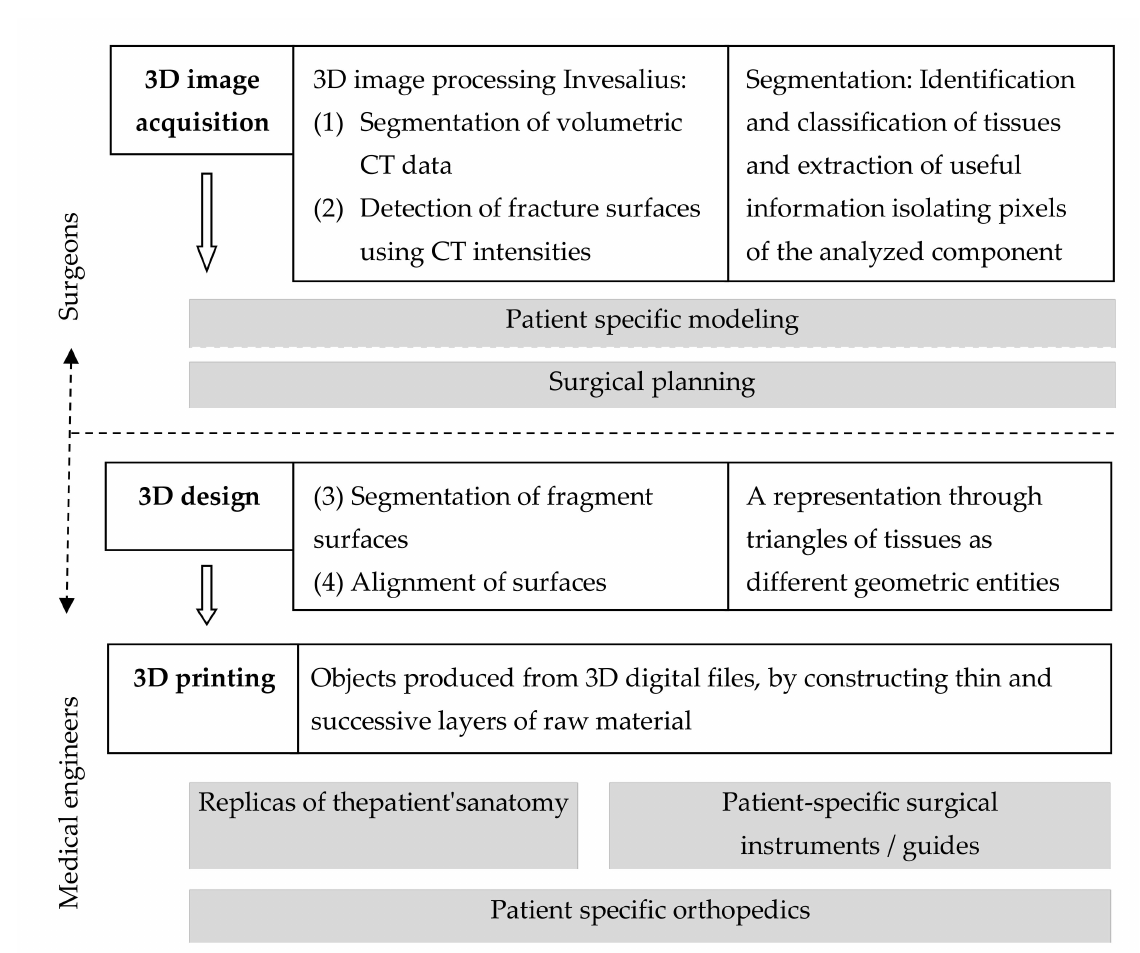
Figure 1. Clinical workflow for structured integration process supported by an alignment algorithm for personalized surgical treatment of